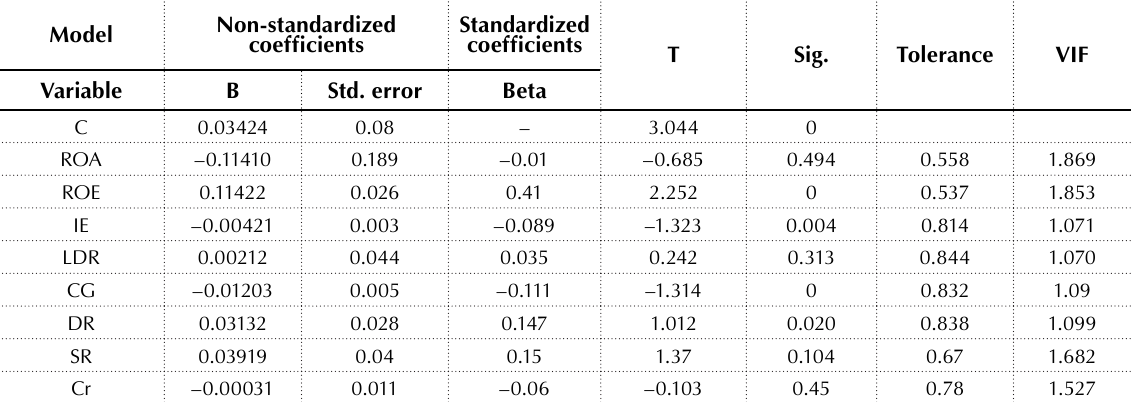
Table 4. Common effect model